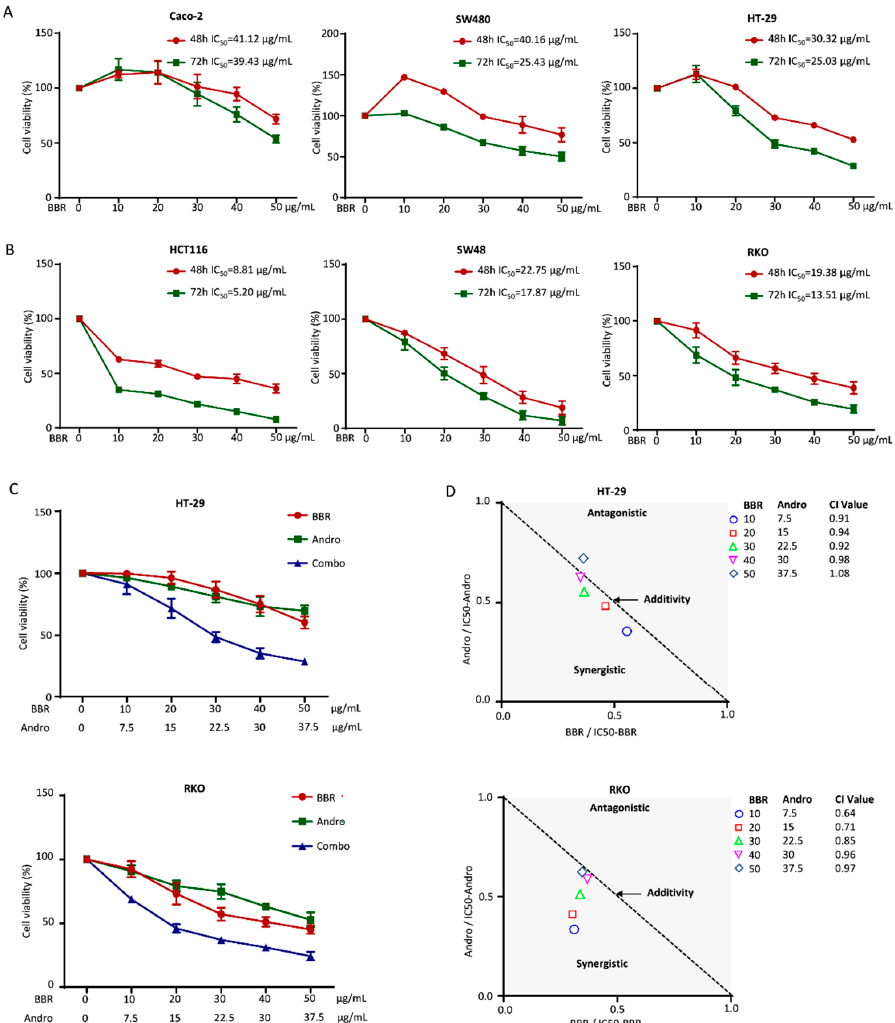
Figure 1. The combination of berberine and Andrographis interactively inhibited the growth of CRC cells. ( A ) Results of the CCK-8 assay showing the viability inhibition of MSI-type CRC cells following exposure to different concentrations of berberine for 48 h or 72 h; ( B ) The cell viability of MSS-type CRC cells treated with different concentrations of berberine for 48 h or 72 h; ( C ) Results of the CCK-8 assay to compare cell viability following treatment with berberine, Andrographis, and their combination for 48 h in the HT-29 and RKO cell lines; ( D ) Isobologram analysis of the CI values based on the results of the CCK-8 assay to determine the synergistic effects of berberine and Andrographis in the HT-29 and RKO cell lines. BBR, berberine; Andro, Andrographis; Combo, combination; CI, combination